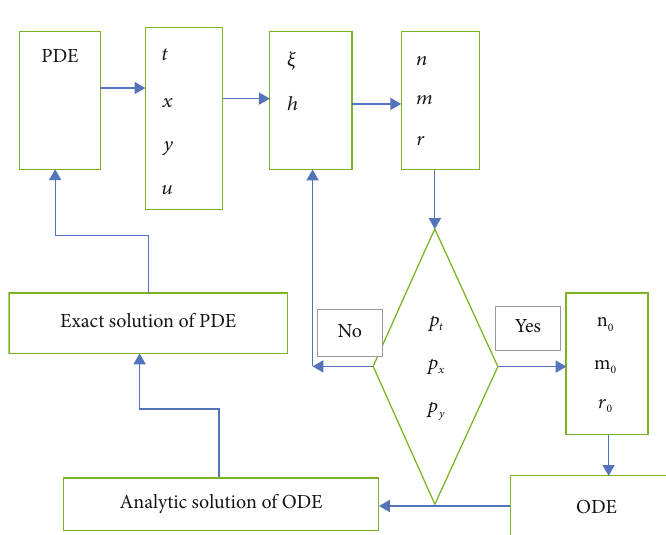
Figure 1: Flow chart of solution of the PDE